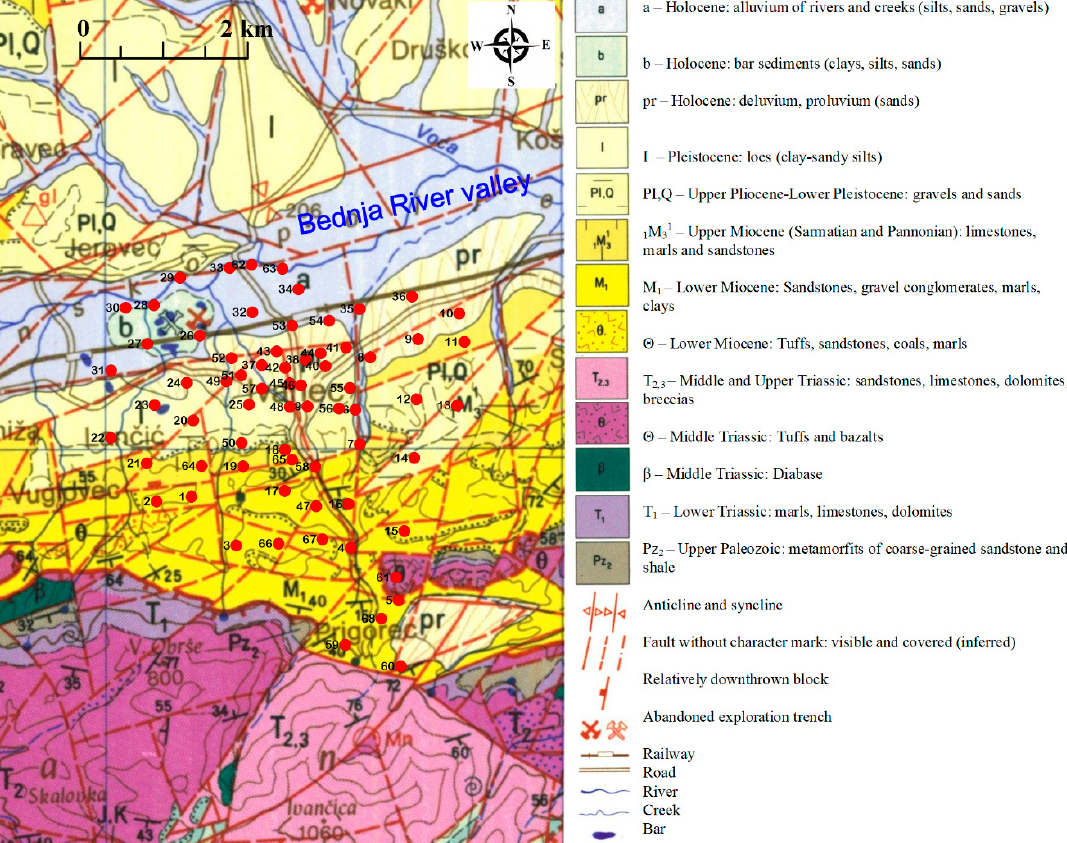
Figure 3. Geological map of the City of Ivanec area between Bednja River valley and Mt. Ivanš č ica (highest point Ivanš č ica at 1060 m elevation). Red circles indicate microtremor measurement locations [36].